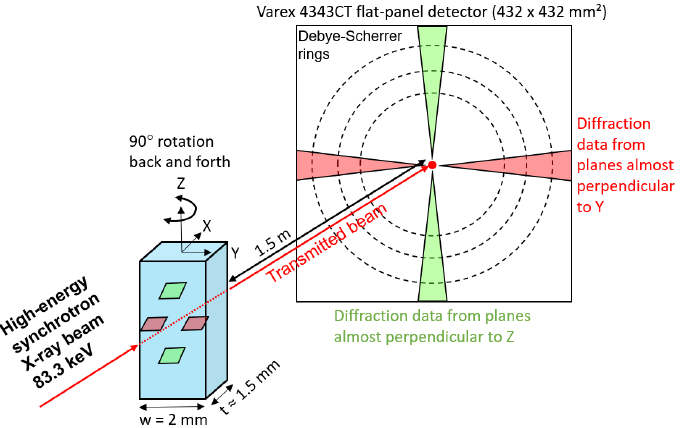
Figure 1. Schematic illustration of experimental setup for the HE-XRD experiments at DESY. For each experiment, the specimen was subjected to a back-and-forth rotation around the z -axis to 90° with an angular speed of 5° per second, while pausing for 1 s at 90°. Then, 2D diffraction patterns were recorded continuously with an exposure time of 1 s. In this manner, a total of 38 diffraction patterns were collected for each specimen. These patterns were subsequently superimposed to reduce the spottiness of diffraction patterns caused by the relatively large grain size of experimental steels compared to the volume exposed to the X-ray beam. The 2D diffraction patterns were then azimuthally integrated (0 – 360°) using the PyFAI software [43,44] to obtain an intensity vs. 2θ ASCII format data. The dif- fraction patterns were further calibrated for the angular positions using a LaB6 specimen supplied by the National Institute of Standards and Technology (NIST). The 1D diffraction patterns were then analyzed to determine the lattice parameter. The X-ray profile shapes were approximated by a pseudo-Voigt function. 3. Results and Discussion 3.1. Thermodynamic Equilibrium Calculations and Solidification Mode Figure 2 shows the pseudo-binary Fe-12Cr-9Ni-3Mn-0.3C-xAl (x = 0 – 7 wt.%) phase diagram calculated by the TCFE9 database of Thermo-Calc. The calculated diagram sug- gests that the equilibrium matrix microstructure at 600 °C consists of ferrite and austenite for 0Al, 1.5Al and 3Al steels but only of ferrite for 4.5Al and 6Al steels. Furthermore, C is stabilized in the form of M 23 C 6 carbides. For 3Al, 4.5Al and 6Al steels, the presence of the B2 phase is also predicted by Thermo-Calc. The type of carbides changes to M 7 C 3 at higher temperatures. The phase diagram also suggests that the solidification of all steels contain- ing 9 wt.% Ni, except for 0Al with an entirely austenitic (A) solidification mode, begins with the formation of ferrite and continues with the formation of austenite (FA solidifica- tion mode). The formation of austenite in the 1.5Al steel begins slightly below liquidus temperature, whereas it is postponed to the latest stages of solidification, namely, slightly above solidus temperature, in the case of 6Al. An overview of solidification modes based on Thermo-Calc calculations is provided in Table 2.